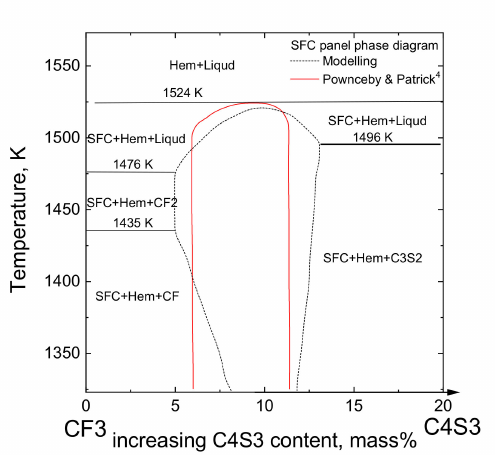
Figure 1. Comparison of the calculated and experimental measured phase stability [4] in the pseudo-binary CaO · 3Fe 2 O 3 -4CaO · 3SiO 2 system in air.